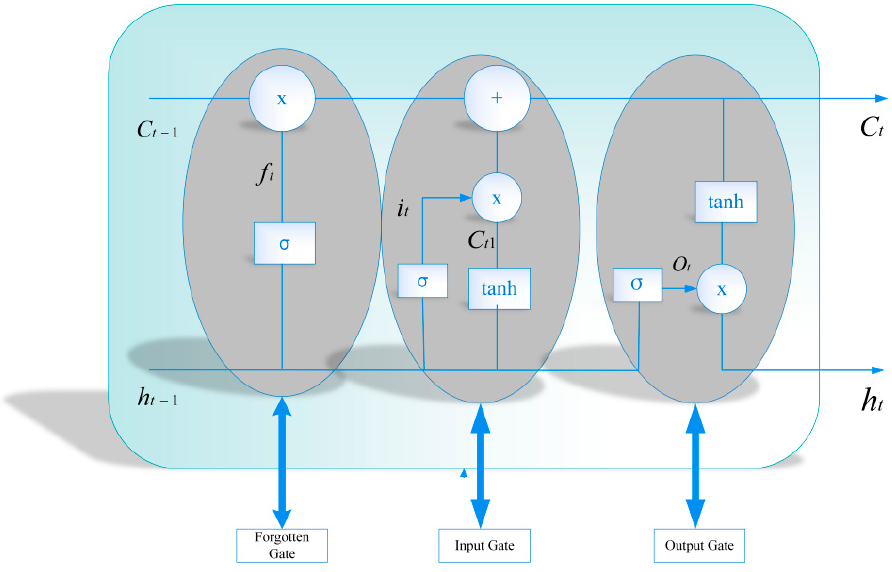
Figure 1. LSTM model structure diagram.